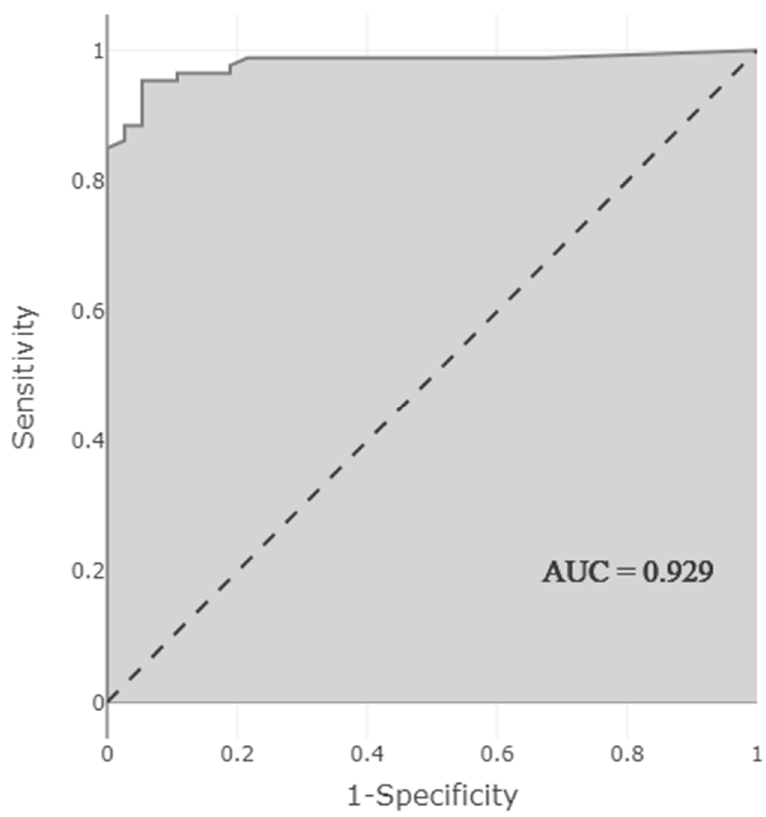
Figure 3. AUC-ROC curve showing the performance of the model predicting the presence of clinically relevant DDI.